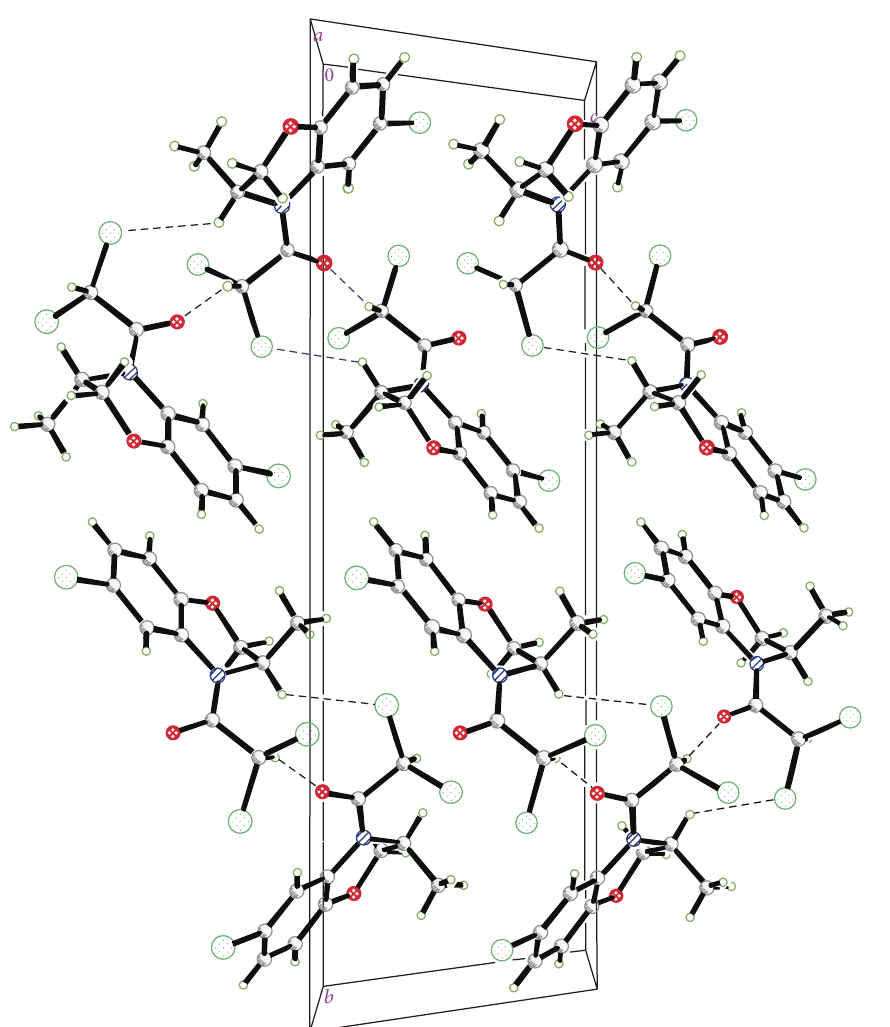
Figure 2: Packing view of the title